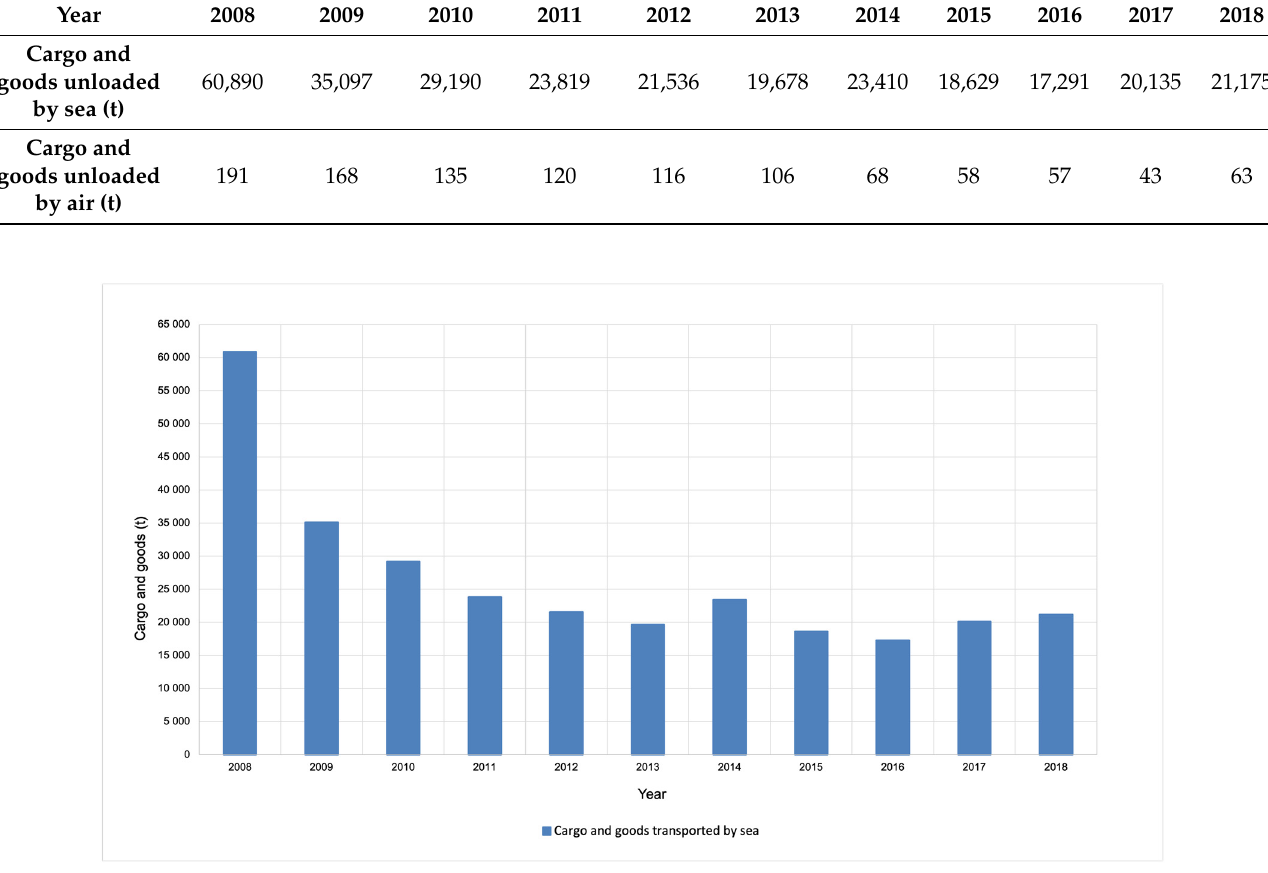
Figure 12. Cargo and goods unloaded by sea in Porto Santo. (Source: Authors).